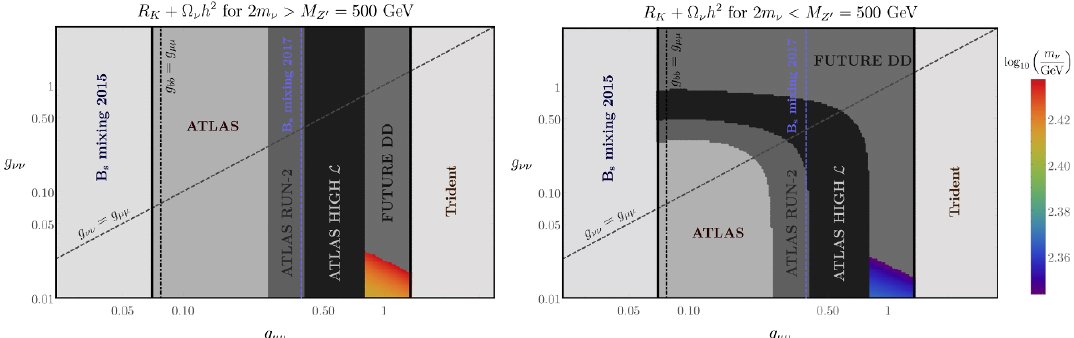
Figure 11 . Projection of future constraints on the parameter space of our model for M Z 0 = 500 GeV. The current ATLAS dimuon limits [66] are scaled with integrated luminosity to L = 200 fb (cid:0) 1 (ATLAS RUN-2) and L = 3000 fb (cid:0) 1 (ATLAS HIGH L ). Future direct detection limits (FUTURE DD) assume that the current XENON1T [95] constraints on the DM-nucleon scattering cross section are improved by two orders of magnitude, which roughly corresponds to the projected sensitivity of LZ [102], DARWIN [103], and Darkside-20k [104]